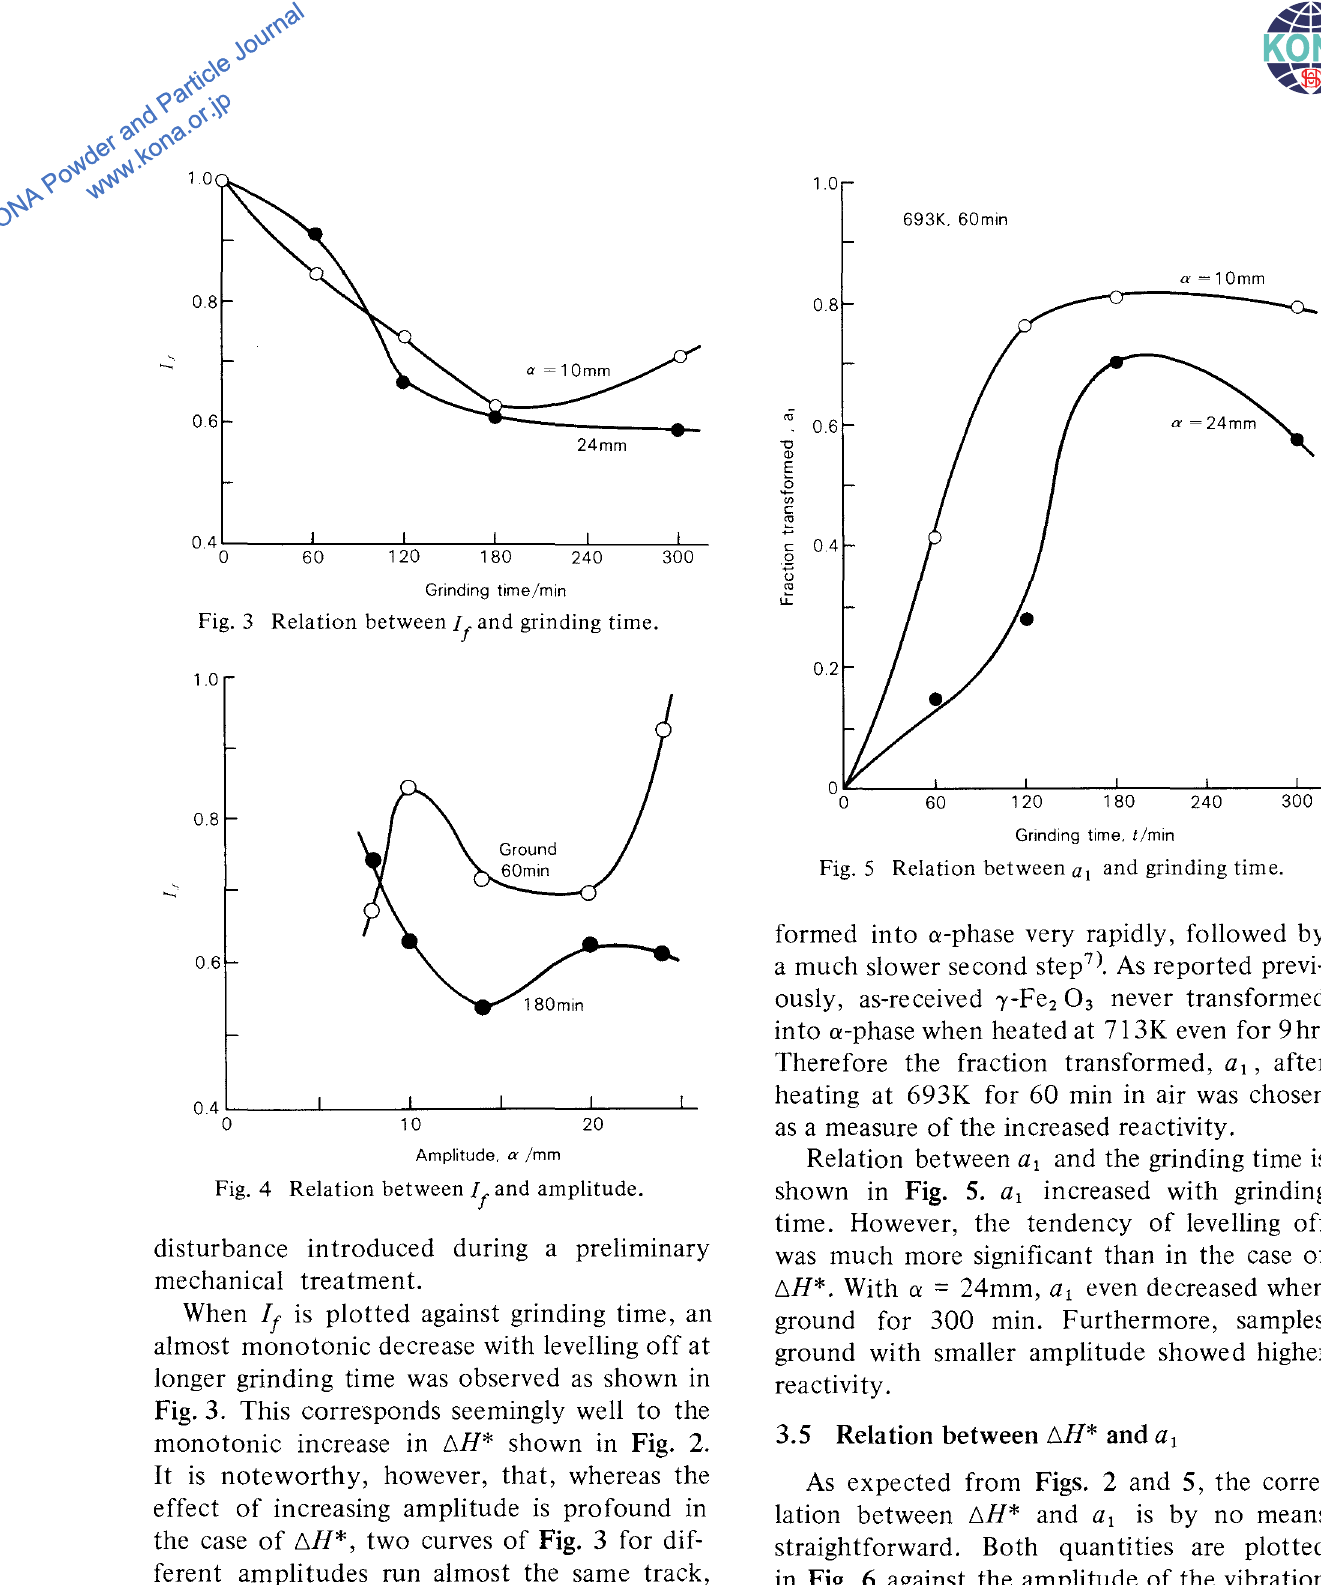
Fig. 3 Relation between If and grinding time.